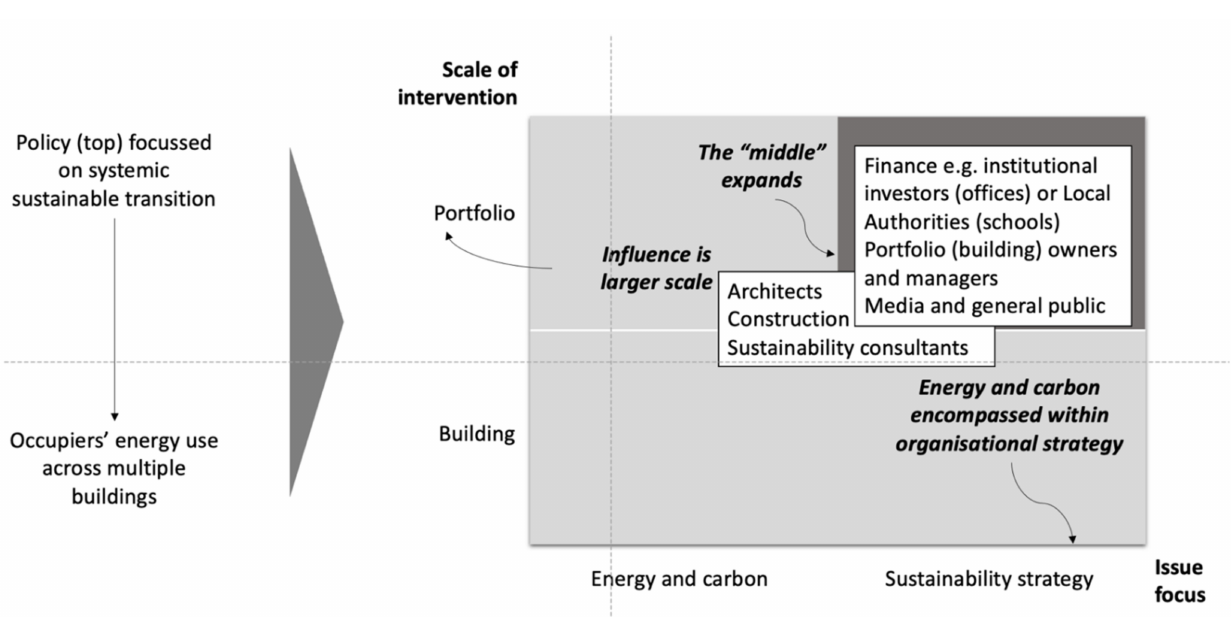
Figure 3. Policy focused on buildings as part of systemic sustainable